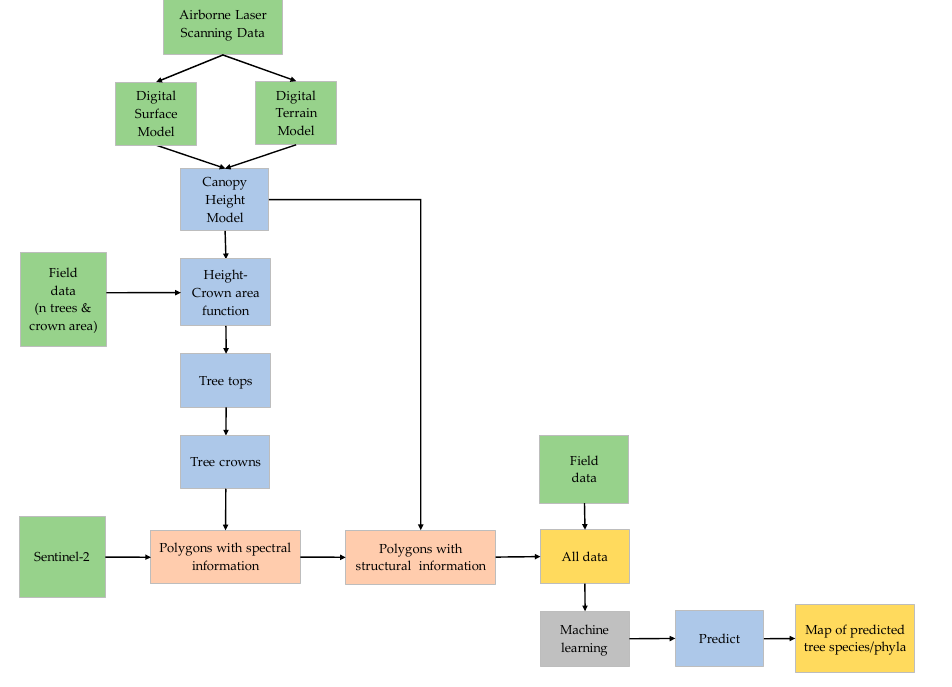
Figure 2. Flowchart showing the methodology.